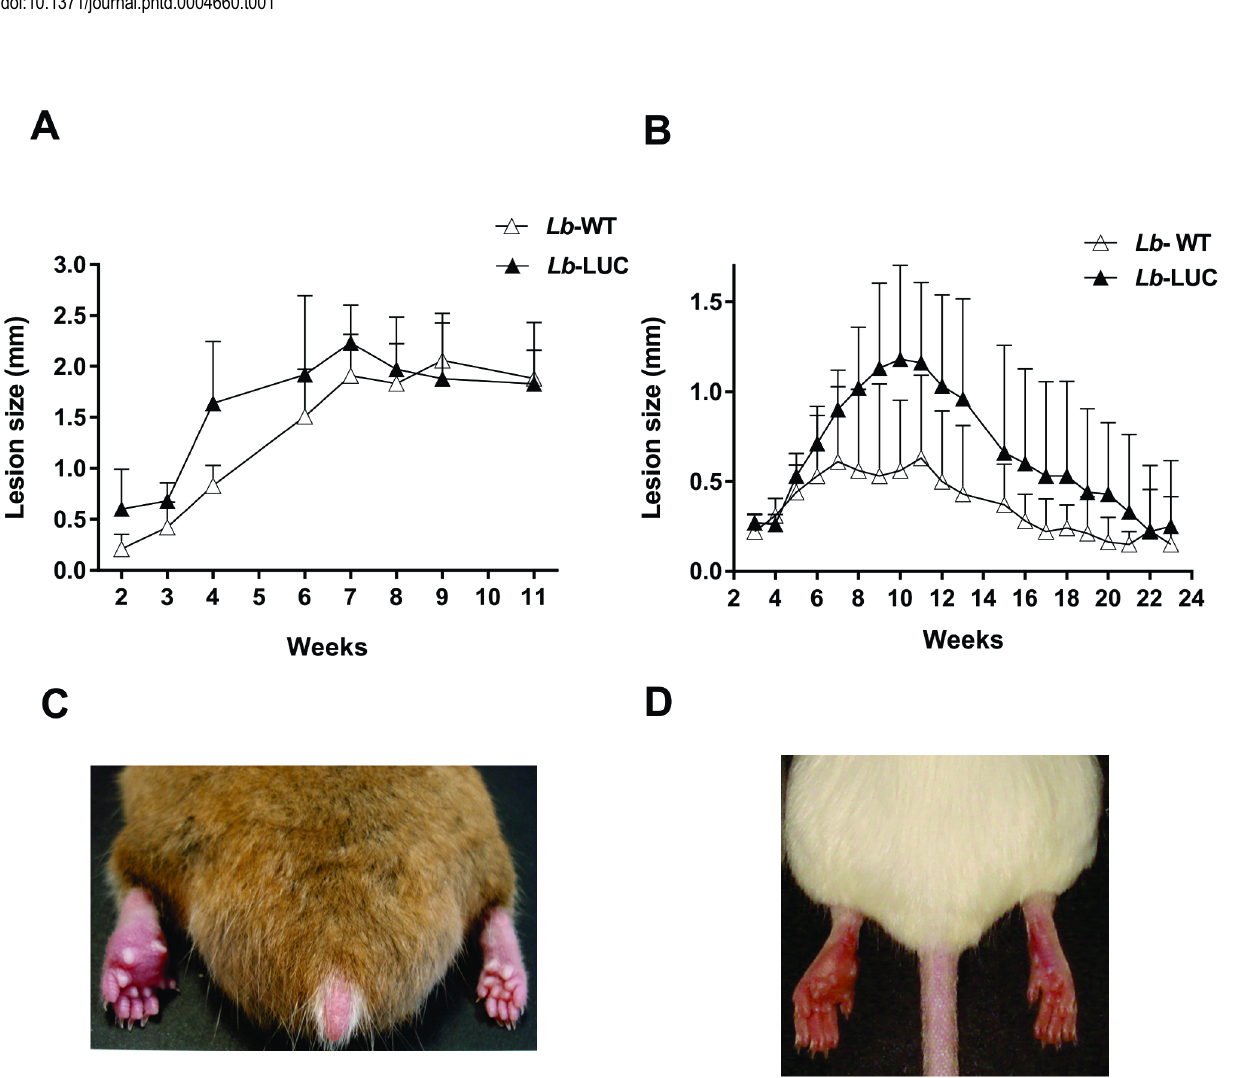
Fig 2. Course of disease after L . braziliensis H3227 inoculation in hamsters and BALB/c mice. Evolution of lesion size in hamsters (A) and BALB/c mice (B) inoculated with Lb -LUC or Lb -WT H3227 strain. Animals were inoculated with 10 6 stationary-phase promastigotes in the left hind footpad and lesion size was measured weekly (five animals per group). Data is the mean and standard deviation from one experiment representative of two independent experiments. Student ’ s t test comparing the area under the curve detected non-statistically significant differences with P = 0.25 (A) and P = 0.11 (B). Representative images of a hamster at the 5 th week (C) and of a BALB/c mouse at the 6 th week post-inoculation (D) with H3227 Lb -LUC parasites. The left footpad (inoculated) and right footpad (control) of a hamster (C) and a BALB/c mouse (D), representative of each group of animals, are